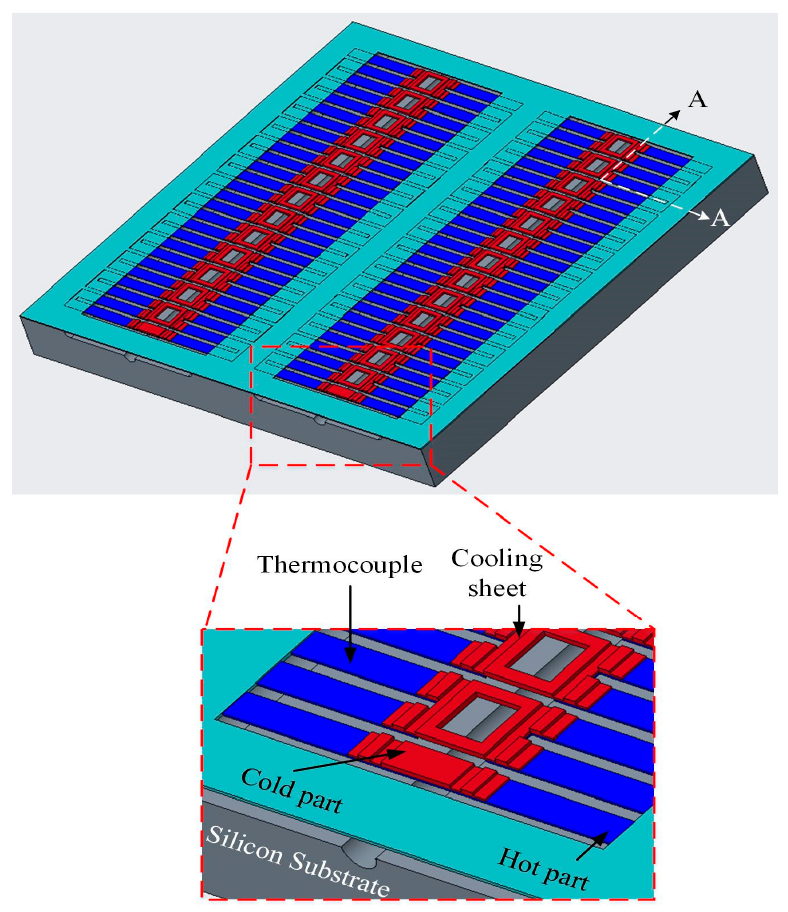
Figure 1. Structure for the TEMH (thermoelectric energy micro harvester).